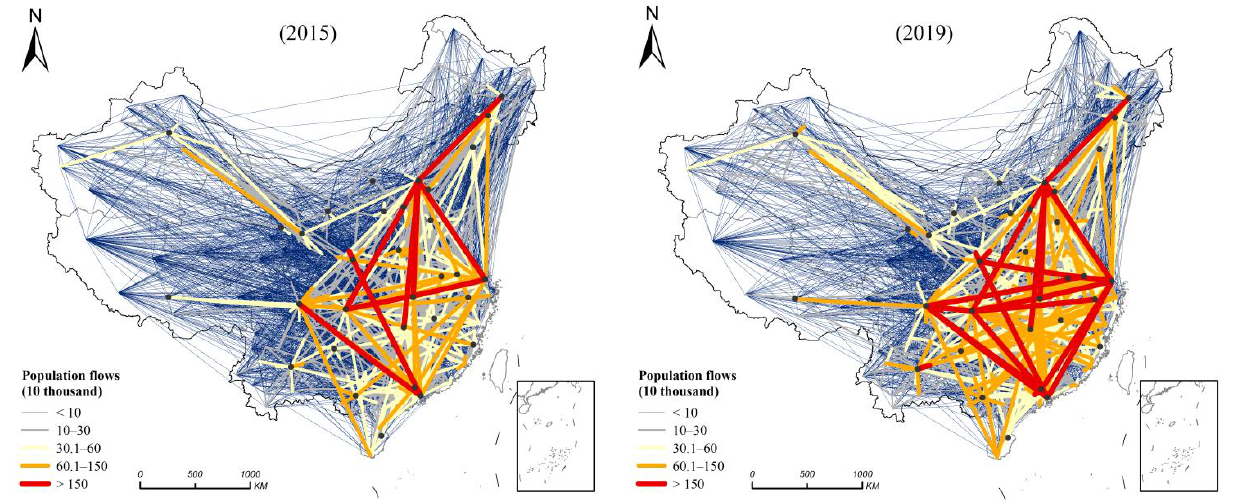
Figure 4. Population flow network during the Spring Festival travel season in China. China’s population flow network has sharp differences between different levels. The first level with population flows greater than 1.5 million person-times is used to identify core cities and major population flow arteries, including Beijing, Shanghai, Guangzhou, Shenzhen, Chongqing, Chengdu, etc., with a high population density in each city. The connection has a strong correlation with the city level and the constraint of geographic spatial distance on population mobility is weakened. In 2019, the population flow in the coastal economic corridors between Shanghai and Guangzhou and Shenzhen increased, and the population flow in multiple cities was upgraded to represent a strong connection.